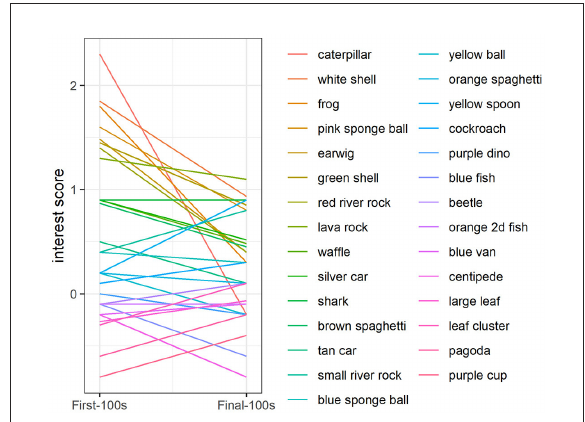
FIGURE4 Variability in object interest at the beginning of the study. During the first 10 object presentations, object ID explained a significant proportion of the variance in zebrafish behavior ( p < 0.01). Interest was quantified as fish presence in the object area (within two body lengths of the novel object) above a baseline period when there was no object present. Colored lines represent object interest scores at the beginning of the study averaged across tanks. The line colors and order of the novel objects in the legend correspond to the plot such that the object that appears first in the legend (“caterpillar”, dark-red line), corresponds to the object with the highest interest score in the First-100s, followed by objects that attracted less interest in the First-100s and colored lines progressing through the rainbow, ending with the last object in the legend (“purple cup”, magenta line), which corresponds to the object with the lowest interest score in the